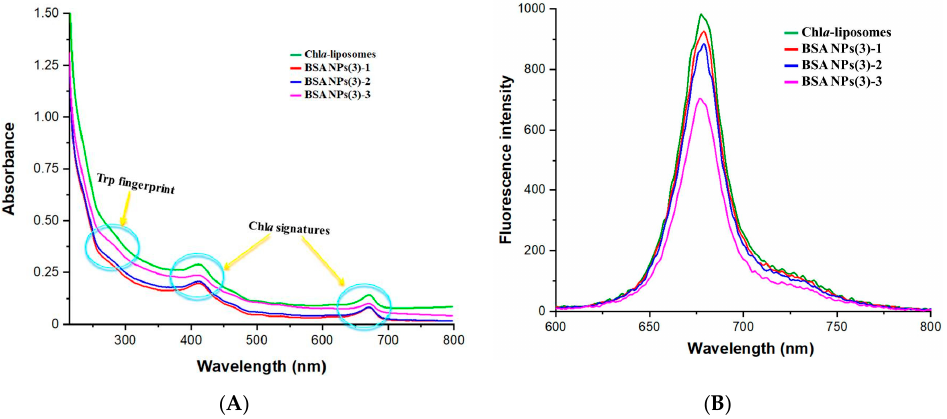
Figure 6. The UV–Vis absorption ( A ) and fluorescence emission spectra ( B ) of Chl a –liposomes (green line, ▬ ) and of biohybrids BSA NPs: BSA NPs(3) ‐ 1 (red line, ▬ ), BSA NPs(3) ‐ 2 (blue line, ▬ ) and BSA NPs(3) ‐ 3 (magenta line, ▬ ) ( v / v ).